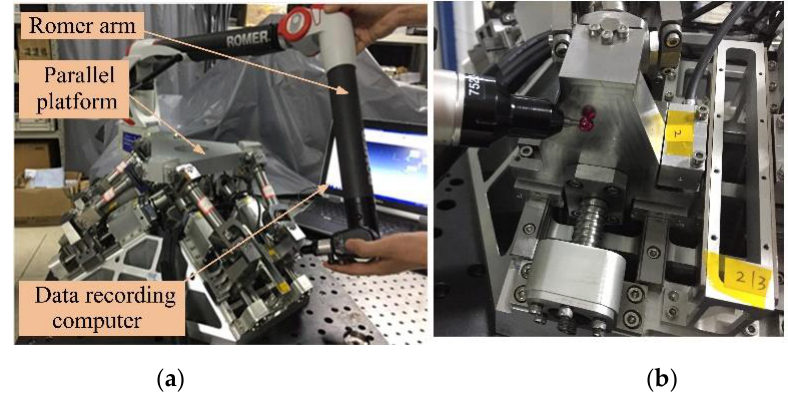
Figure 20. Calibration of the initial parallel platform position: ( a ) Overview; ( b ) Details.